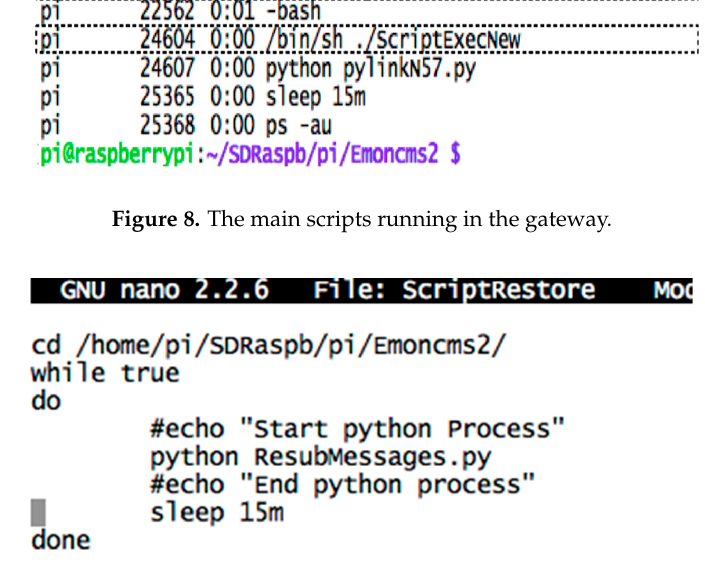
Figure 9. Shell script managing the periodic execution of the message resubmissions.